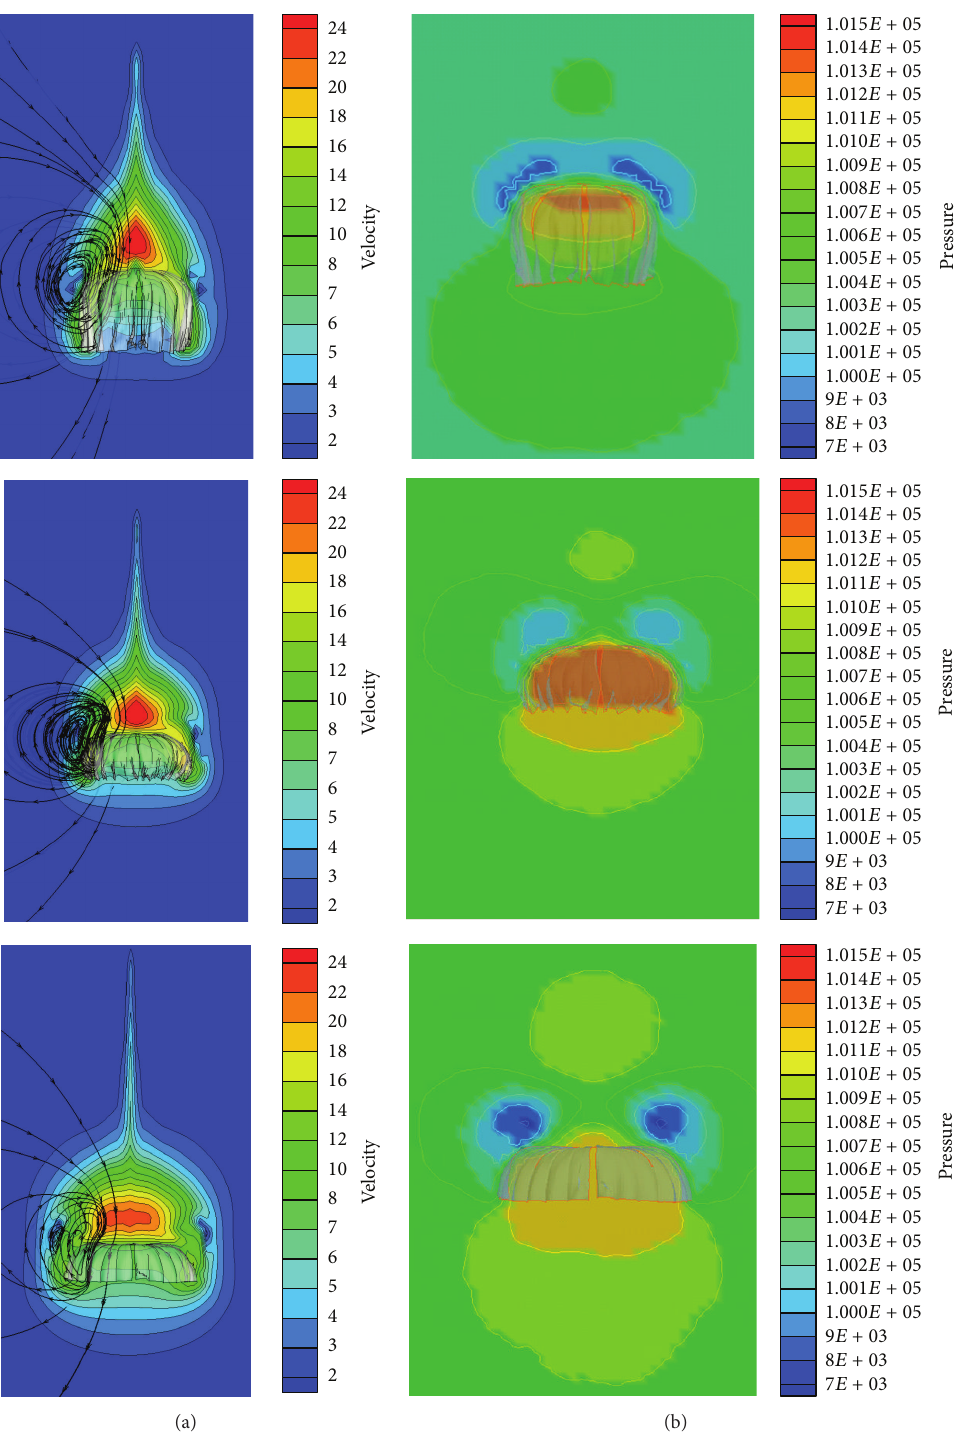
Figure 9: CFD pressure distributions and velocity vectors contours during opening ((a) is velocity vectors results and (b) is pressure distribution